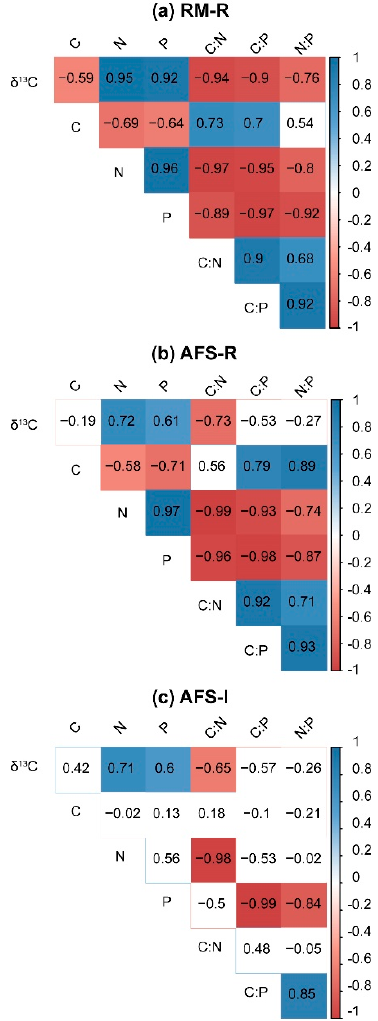
Figure 5. The Pearson correlations between all leaf parameters (i.e., leaf δ 13 C values; leaf C, N, and P concentrations; and leaf C/N, C/P, and N/P ratios) of ( a ) the rubber trees in the RM and the leaves of ( b ) the rubber trees and ( c ) their intercrops in the RS-AFS. The color indicates the sign of the correlation (blue indicates a positive correlation, and red indicates a negative correlation). All the correlation coefficients in the red and blue boxes reached a significant level ( p < 0.05). See Figure 3 for abbreviations.